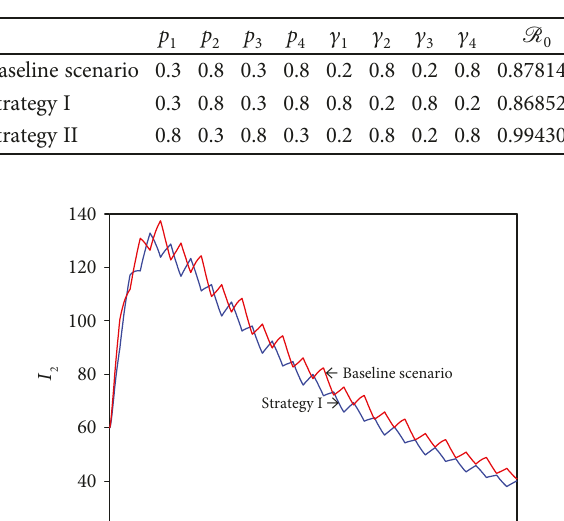
= 1 801682 > 1 . 0 γ σ and σ on the disease control.